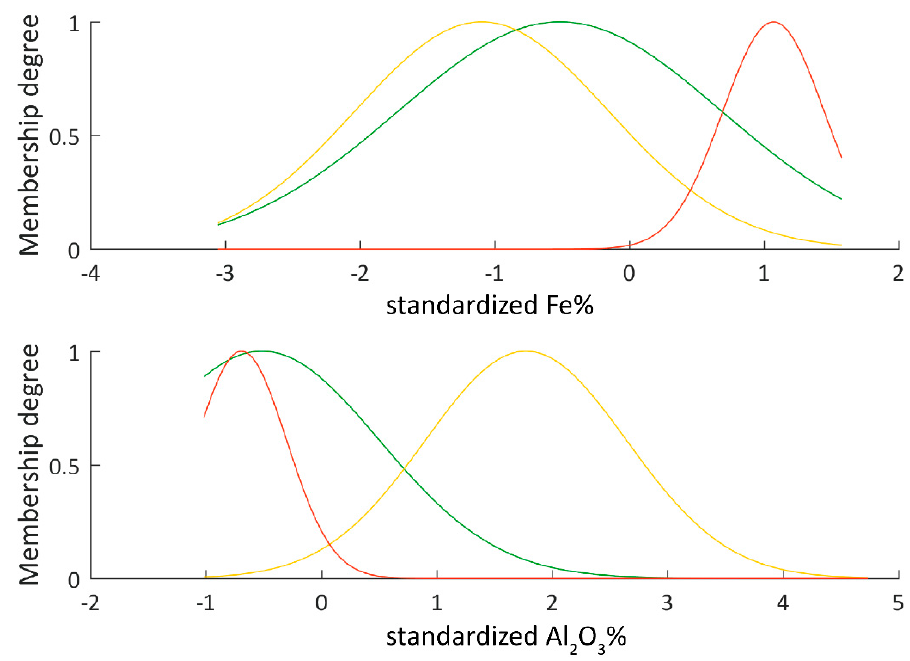
Figure 6. Adjusted membership functions after training. The functions are spanning a considerably lower range than the initially defined functions in Figure 5 and thus reflect the desired output classes better.